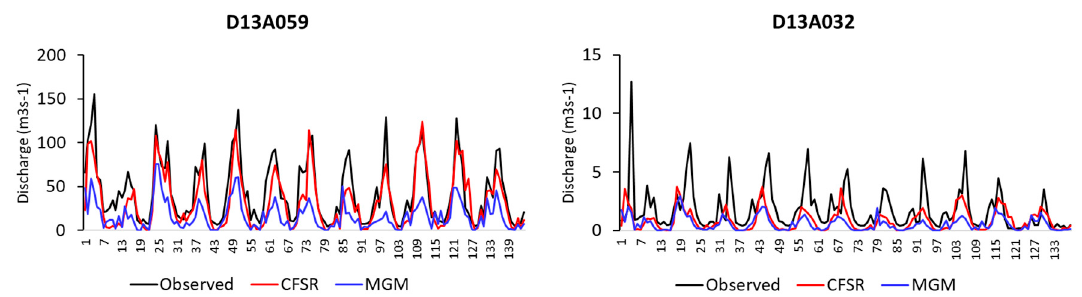
Figure 7. Simulated and observed streamflow for each climate dataset at stations no D13A059 and D13A032. (model results before calibration).